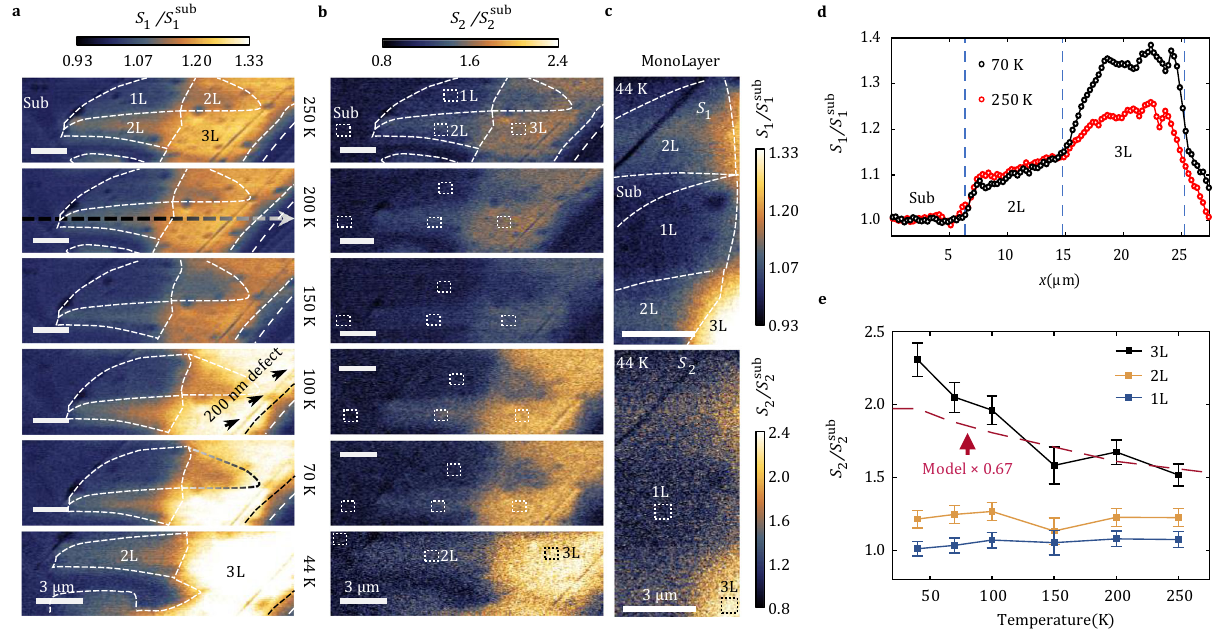
Fig. 2 Temperature-dependent near- fi eld maps of nano-THz response of WTe 2 micro-crystals. The scale bars in all panels are 3 µ m. a Near- fi eld images of the normalized amplitude contrast S 1 = S sub of nearly identical regions at 6 different temperatures between 250K and 70 K. The 44 K image includes only 1 2L and 3L regions and the 1L region is shown in Fig. 2c. Broadband THz signal utilized in these images shows intensity peaked at 0.6 THz. The signal due to the SiO 2 /Si substrate ( S sub ) has negligible temperature dependence in the THz range studied here. The horizontal dashed arrow in the panel at 200 K 1 indicates the scanning line-cut used to construct the plot in Fig. d . Micrometer-sized dark spots also visible in the topographic AFM contrast can be attributed to bubbles in the encapsulated structures. b Near- fi eld S 2 = S sub images taken simultaneously with S 1 = S sub . c Enlarged images zoomed at the 2 1 = S sub interface between 1 L and 2 L, 1 L and the substrate. d S line-cut (averaged over 5 neighboring pixels) at 250 K and 70 K. The line-cut corresponds to 1 1 the arrow in Fig. 2a. e Normalized S 2 signals averaged in the regions indicated in the S 2 images (white dashed boxes) for the substrate and for 1L, 2L, 3L regions of WTe 2 . The fi lled squares are experimental data. The error-bars are the standard deviations of the extracted data. The dashed line is a model calculation using the dielectric properties of the bulk material. The magnitude of the signal for bulk dielectric properties is rescaled by a factor of 0.67 to be comparable with 3L WTe 2